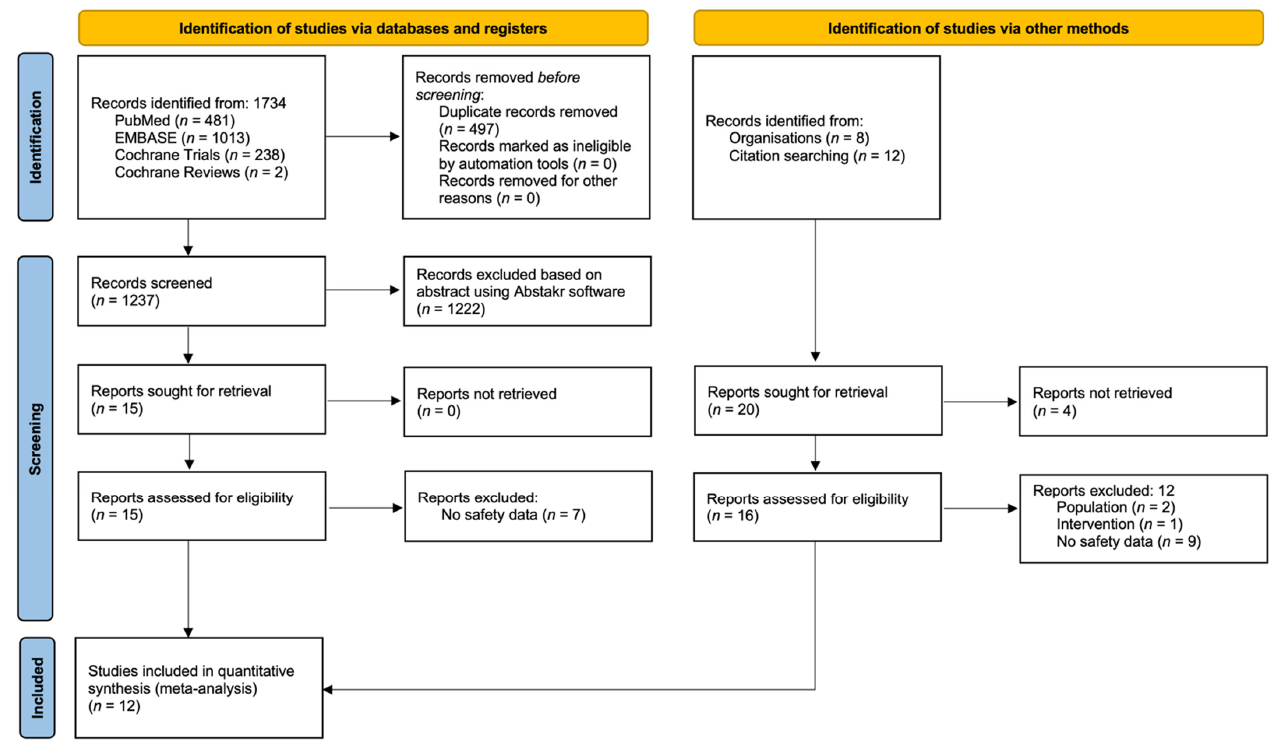
Figure 1. PRISMA flow diagram highlighting study selection process . Twelve trials met the inclusion criteria, providing safety data for use of Cerebrolysin for 2202 from a total of 2274 randomized patients in the studies selected for formal analy-